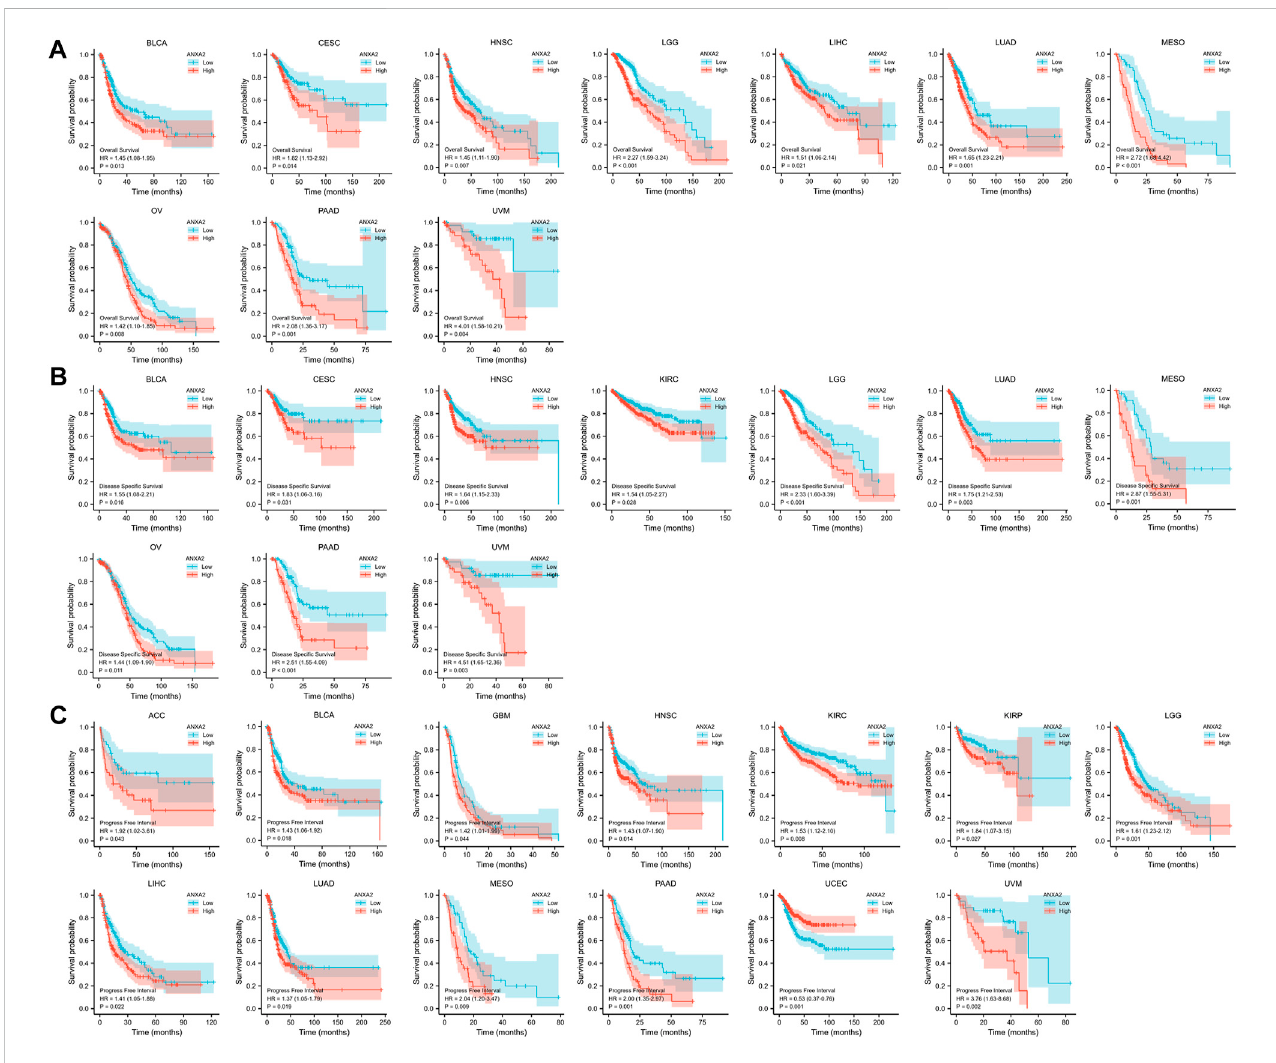
FIGURE 4 Kaplan-Meier analysis of the association between ANXA2 expression and (A) OS, (B) DSS and (C)